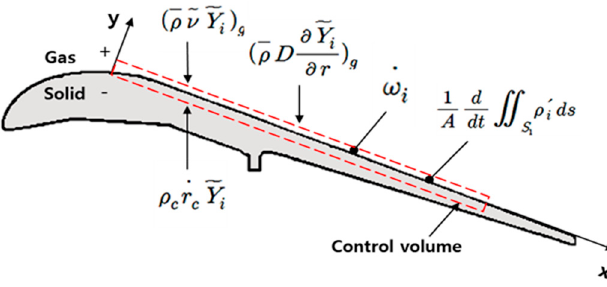
Figure 2. Surface mass balance at solid-gas interface.